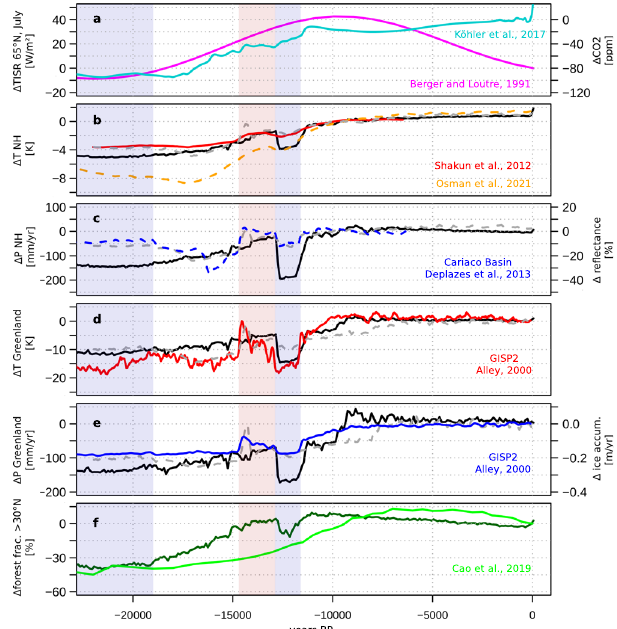
Fig. 1 | Mean climate and forest cover change in the Northern Hemisphere. Temperature and precipitation reconstructions for the last 22000 years before present (BP) compared to the transient MPI-ESM 1.2 simulation (black) and TraCE- 21ka simulation 29 (grey). a July insolation anomaly to 0 ka ( Δ TISR) at 65°N 78 (magenta) and CO 2 forcing anomaly to pre-industrial 67 (turquoise) as used as for- cing in this simulation. b Northern Hemisphere (NH) temperature anomaly reconstructed by Osman et al. 30 (orange) and Shakun et al. 31 (red). c simulated NH precipitation change vs. anomaly to Holocene mean (11.5 – 6.5 ka) in total re fl ec- tance in Cariaco basin sediments 79 (blue), assuming that tropical precipitation largely controls the overall NH dynamics. d GISP2 Greenland temperature anomaly 32 to pre-industrial (PI) (red). e GISP2 Greenland ice accumulation 32 (blue) vs simulated Greenland precipitation as anomaly to pre-industrial. f Reconstructed 28 (light green) and simulated (dark green) NH forest biome cover fractionasdifferenceto0ka.Thelastglacialmaximumperiod(22 – 19ka,lightblue shading), Bølling/Allerød (14.6 – 12.9 ka, light red shading) and the Younger Dryas period (12.9 – 11.6 ka, light blue shading) are